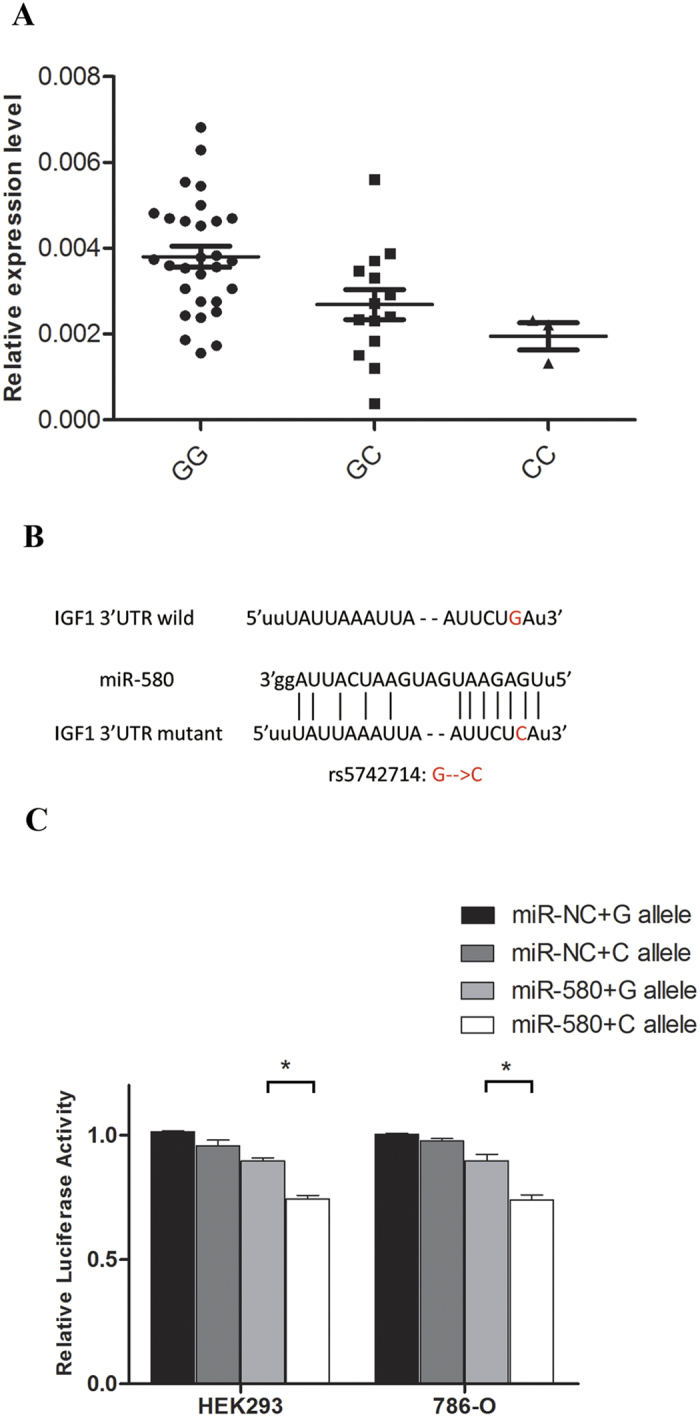
Effect of IGF1 rs5742714 polymorphism on IGF1 expression.(A) Association between IGF1 expression in renal tissues and IGF1 rs5742714 genotypes. Compared to individuals with the rs5742714 GG genotype, individuals with the rs5742714 GC or CC genotype were associated with significantly decreased IGF1 mRNA levels (P = 0.013 and P = 0.017, respectively); (B) Bioinformatics analysis predicted a binding site between miR-580 and IGF1; (C) Transient transfection of reporter and mimics into HEK293 and 786-o cell lines. Luciferase activity was measured using a Dual-Luciferase Reporter Assay System (Promega). Values are mean ± SD from more than three separate experiments that were each performed in triplicate. *Indicates a significant difference (P < 0.05). There is significant difference between Group C, which were transfected with miR-580 mimics and pGL3-IGF1-G and Group D, which were transfected with miR-580 mimics and pGL3-IGF1-C.